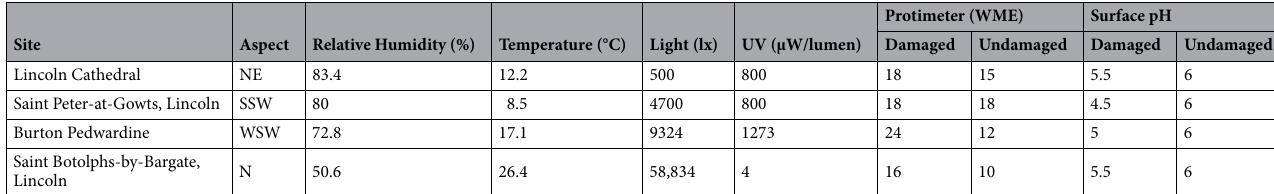
Table 1. Environmental and surface measurements taken at each site. Environmental measurements were relative humidity, temperature, light and UV. Surface measurements were surface dampness using a protimeter, and surface pH, data shown is the mean for sampling where n >